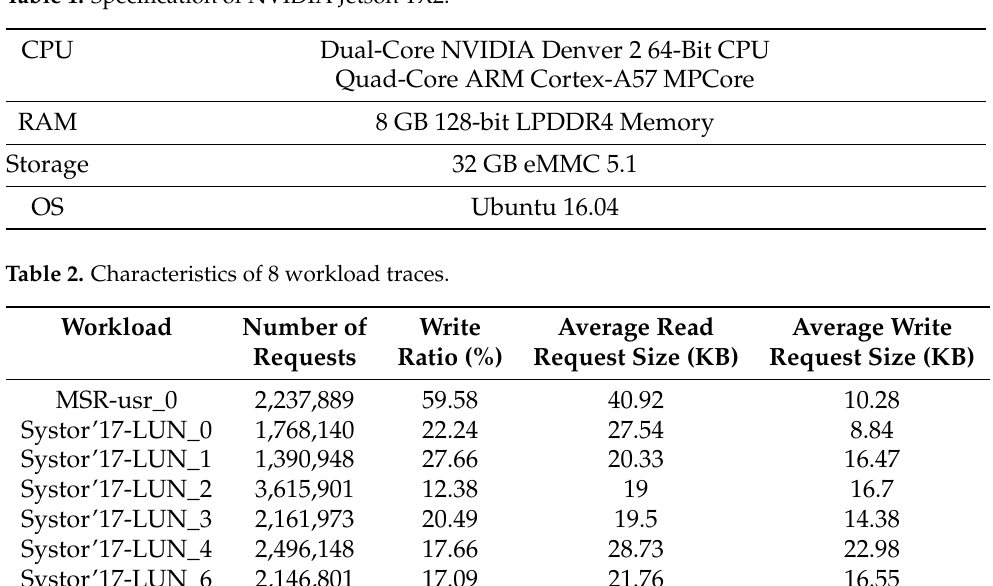
Table 1. Specification of NVIDIA Jetson TX2.